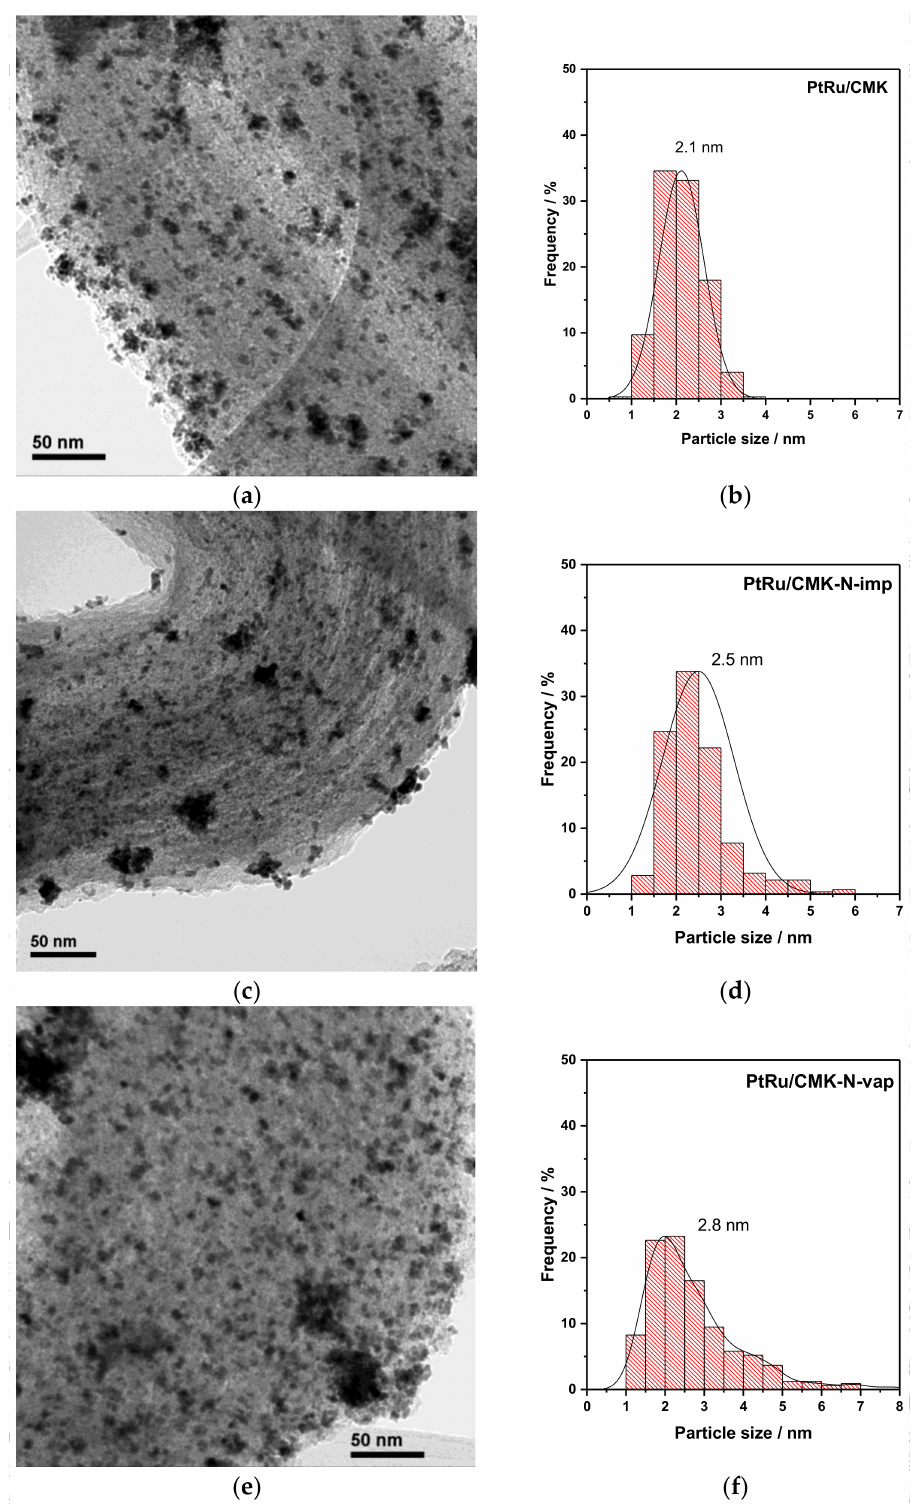
Figure 3. TEM images of ( a ) PtRu/CMK; ( c ) PtRu/CMK-N-imp and ( e ) PtRu/CMK-N-vap catalysts. PtRu particle size histograms of ( b ) PtRu/CMK; ( d ) PtRu/CMK-N-imp and ( f ) PtRu/CMK-N-vap